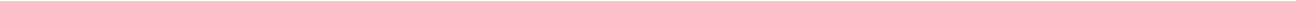
Figure 6 | ASXL2 maintains transcriptional programs through H3K27ac and H3K4me1/2. ( a ) Scatter plots with kernel density estimation showing correlations between change in H3K27ac and H3K4me1/2, and changes in gene expression in WTand Asxl2 (cid:2) / (cid:2) LK cells. Grey and red points represent all expressed genes and DEGs, respectively. Solid line, linear fit. Spearman’s correlation coefficient R -values are shown, P o 10 (cid:2) 7 for all correlation tests. X and Y axes show the log 2 transformed fold change (log 2 FC) for each histone enrichment and mRNA expression level, respectively. ( b ) Boxplot displaying enrichment difference in H3K27ac, H3K4me1 and H3K4me2 at increased (up) and decreased (down) enrichment regions between WTand Asxl2 (cid:2) / (cid:2) LK cells. Y axis shows the log 2 FC in histone modification. ** P o 0.001 (unpaired Student t -test). ( c ) Line plots representing mRNA expression differences for genes with increased and/or decreased signals in H3K27ac, H3K4me1 and H3K4me2 between WTand Asxl2 (cid:2) / (cid:2) LK cells. X axis and Y axis with log 2 scale show the rank of genes with differential signals according to the degree of expression change in decreasing order. ( d ) Heatmap representing KEGG pathway enriched by the genes with differentially enriched regions (DERs) of H3K27ac, H3K4me1 and H3K4me2. Row and column represent KEGG pathway and gene set, respectively. Colour scale indicates enrichment significance. The number in each cell shows the number of enriched genes in this pathway. Up and down represent genes with increased and decreased signals, respectively. ( e ) Representative genome browser tracks showing H3K27ac, H3K4me1 and H3K4me2 enrichment on promoter regions of Prdm16 and Fas , as well as their fold change between WTand Asxl2 (cid:2) / (cid:2) LK cells. The red box indicates